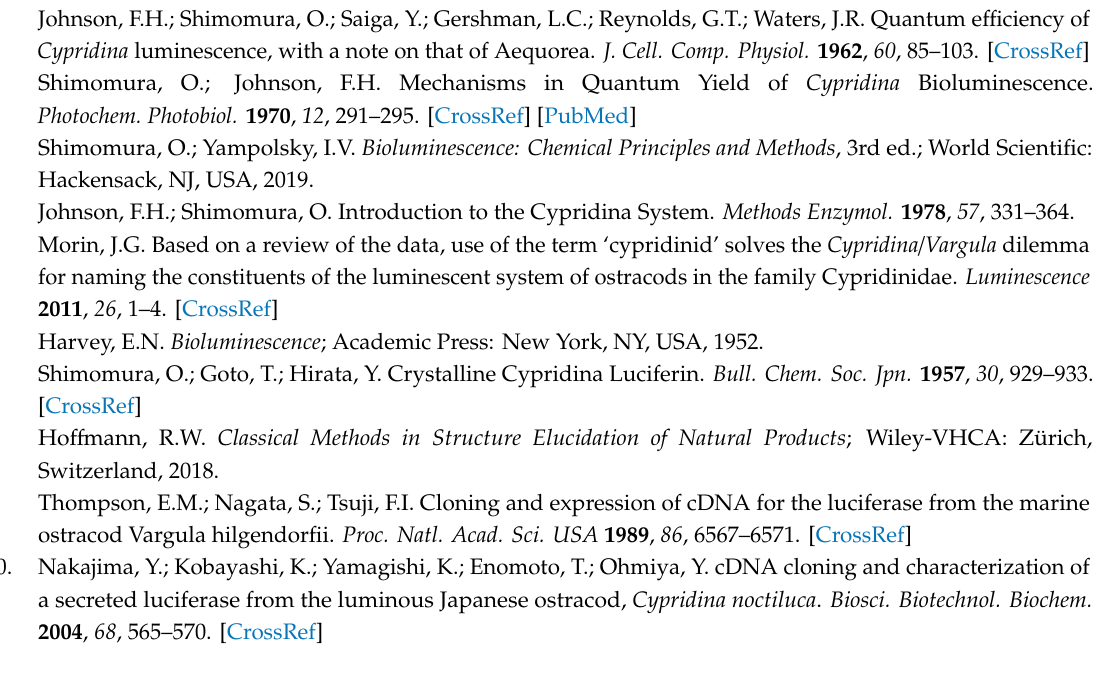
Figure A5. Partial alignment of hAGP with CLases in the region where the amino acid sequence similarity was found in BlastP analysis: CLase1 and CLase2 indicate CLase from C. noctiluca and CLase from V. hilgendorfii , respectively. Gaps are represented as dashes (-). Numbers in parentheses indicate the positions of initial and last amino acid residues. Red characters indicate amino acids involved in the drug-binding ability of hAGP [34]. Navy-shaded characters marked with an asterisk (*) indicate identical amino acid residues. Steel blue-shaded characters marked with a colon (:) indicate sites belonging to group exhibiting strong similarity. Light blue-shaded characters marked with a period (.) indicate sites belonging to a group exhibiting weak similarity. The site similarity followed the criteria of ClustalW [51].